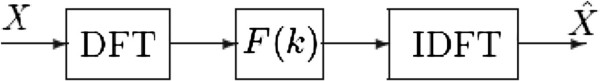
The flow chart of the proposed scheme to improve the reconstruction performance.